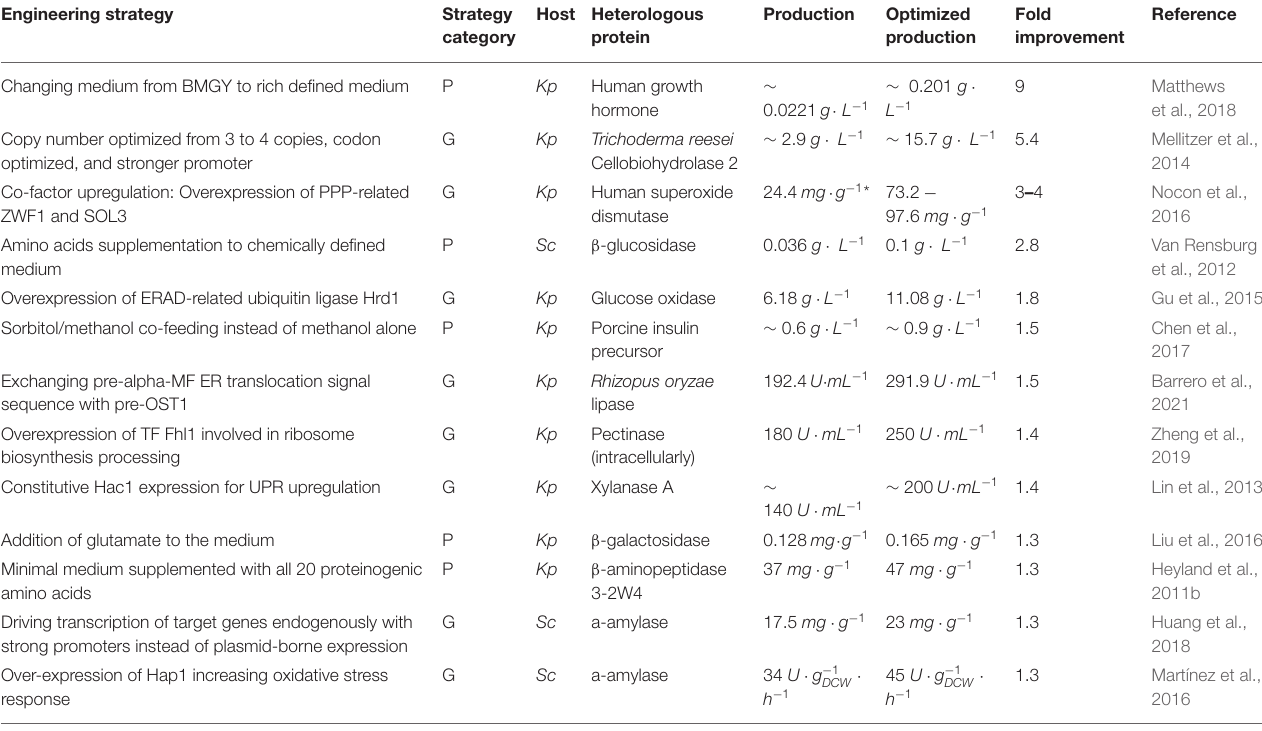
TABLE 2 | Strategies to improve production from burdened yeast cell